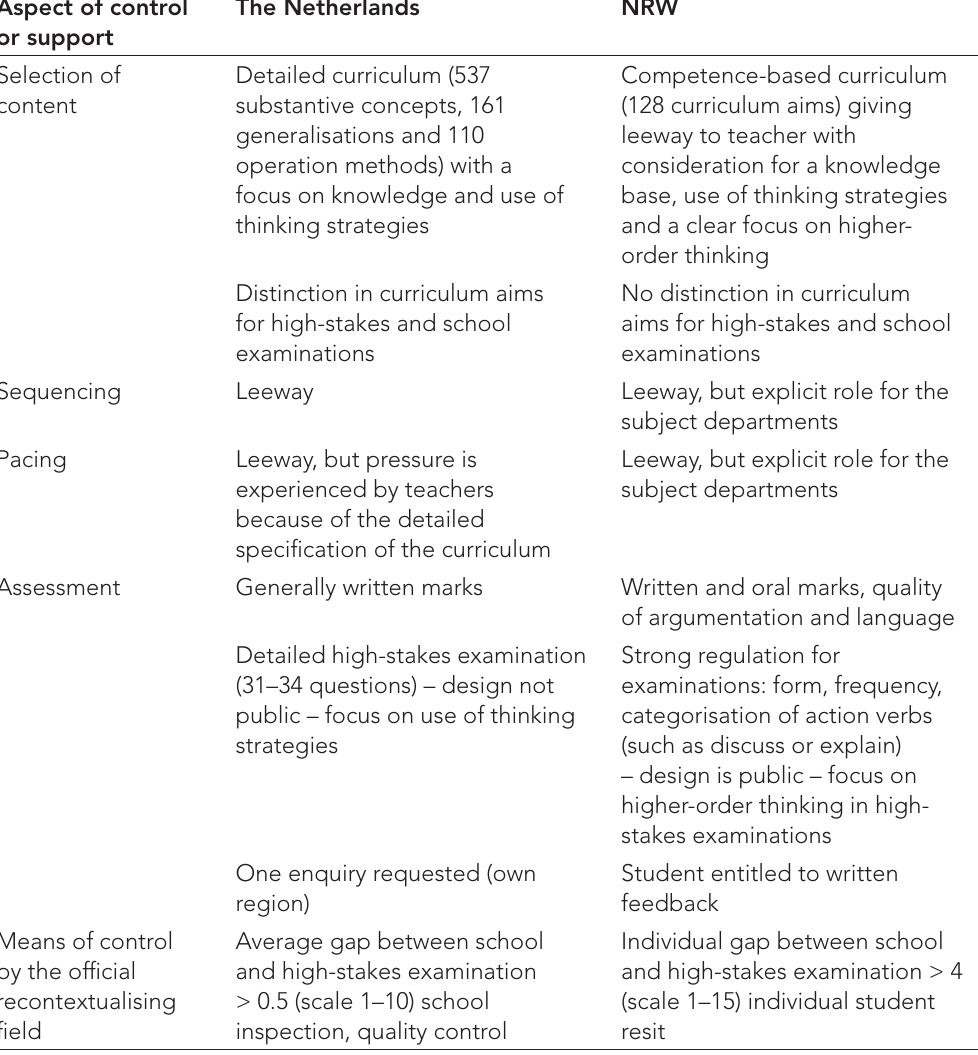
Table 2: Aspects of control and support with regard to higher-order thinking tasks in the Netherlands and NRW (Source: Authors,